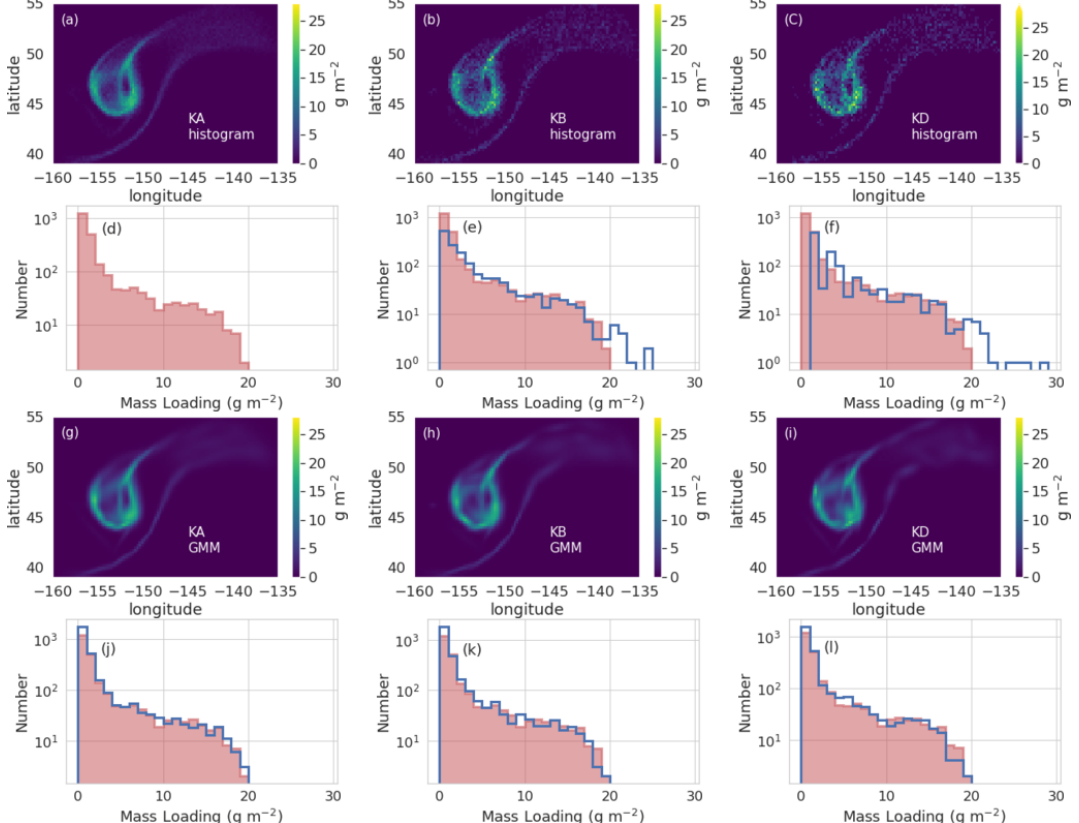
Figure 4. Mass loading from simulations of the 2008 eruption of Kasatochi. The first and third rows ( a – c , f , h , i ) display plots of mass loading with the simulation used and method of density reconstruction noted in the bottom right corner. The GMM used 50 Gaussians and output displayed at the same resolution as the histogram plots (0.25 ◦ × 0.25 ◦ grid). Directly below each mass loading plot is a histogram of the mass loading values with a threshold of 0.01 g m − 2 applied. The histogram for ( a ) is displayed as the red shaded region in each histogram plot for easy